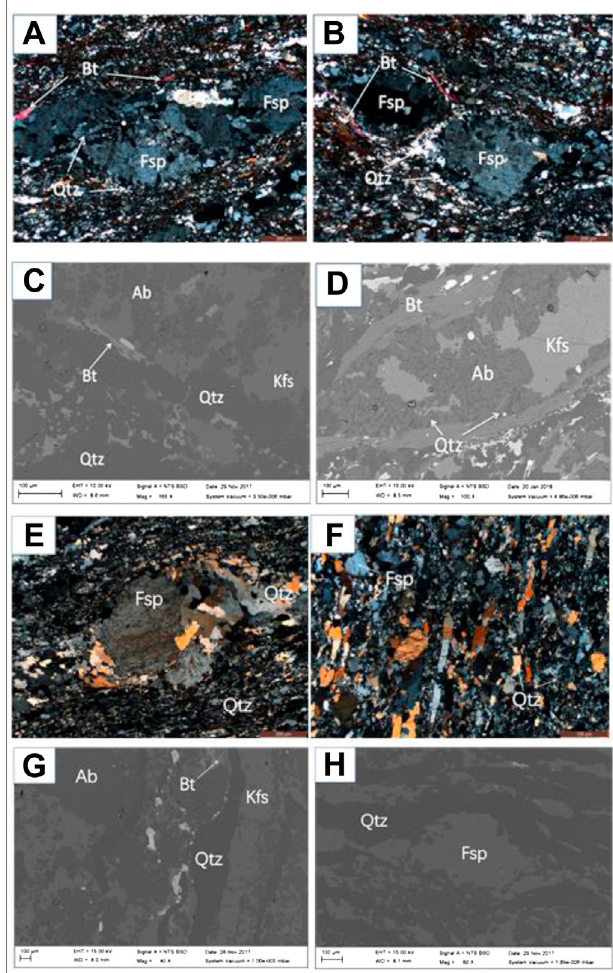
FIGURE 3 | Microstructure of mylonite under optical microscopy (OM) and scanning electron microscope (SEM). (A) and (B) images of 110827-2 under OM (crossed polarized light), (C) and (D) images of 110827-2 under SEM, (E) imageofY11-3underOM(crossedpolarizedlight), (F) imageof 110829-1 under OM (crossed polarized light), (G) image of 110829-1 under SEM, and (H) image of Y11-3 under SEM. (Qtz, quartz; Fsp, feldspar; Bt, biotite; Ab, albite; Kfs,